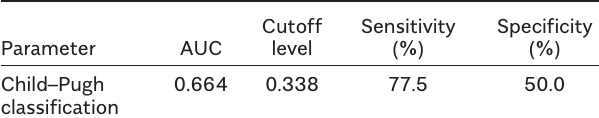
Table 1. Comparison of Conventional Parameters between the 2 Groups